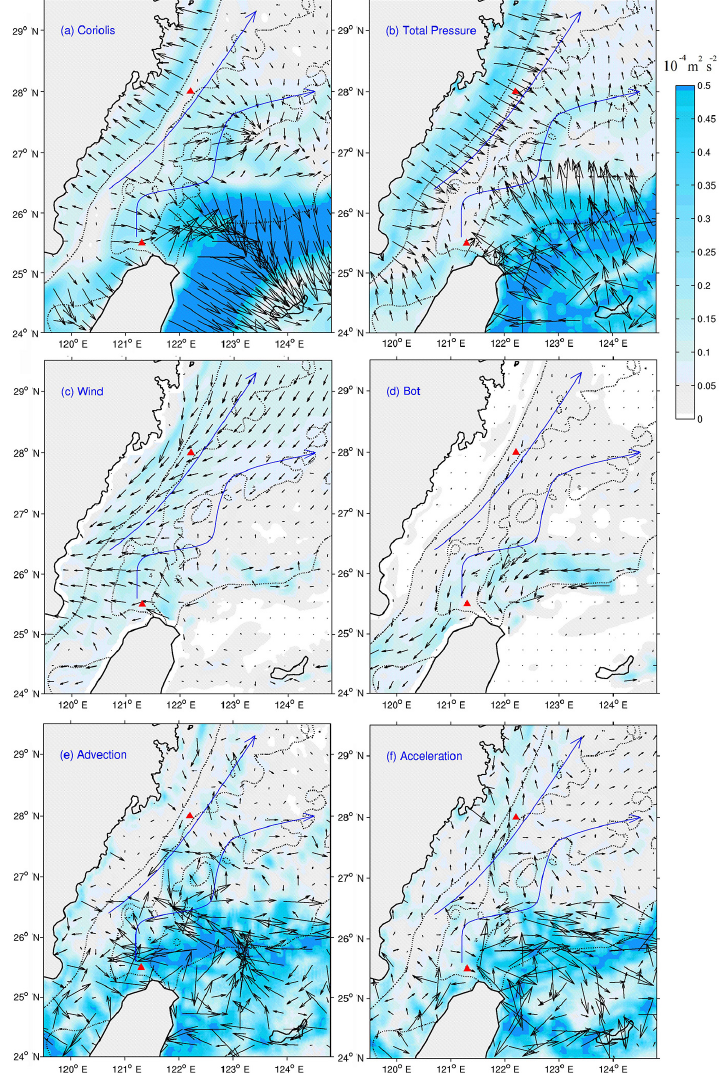
Figure 12. The effects of Coriolis force (a) , total pressure (b) , surface friction (c) , bottom friction (d) , advection (e) and local acceleration (f) for water column in winter according to Eq. (5) (shown by black arrows with the color representing the magnitude; units: 10 − 4 m 2 s − 2 ). The two blue arrows indicate the two TWC branches. The two triangles indicate the two regions with significant fluctuation north of Taiwan (P1) and in the inshore area